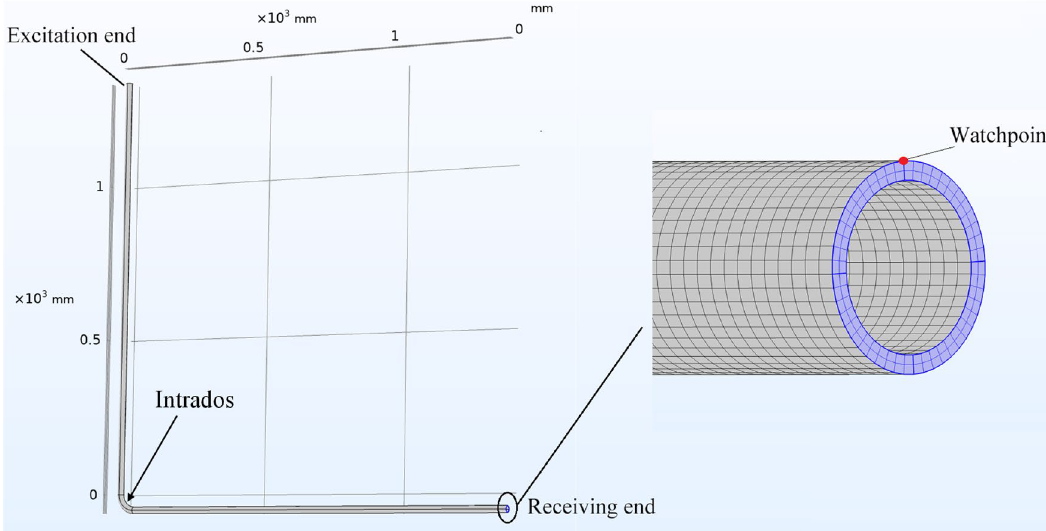
Figure 7. Finite-element modeling of test pipe.